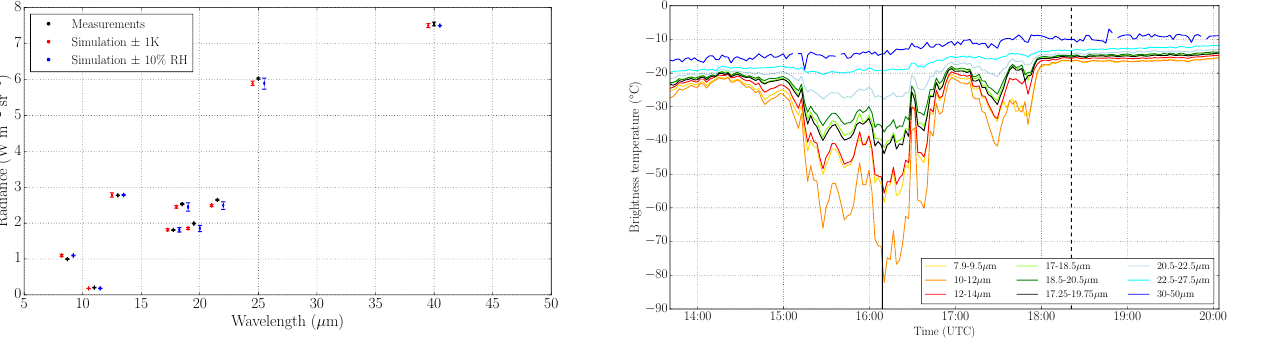
Figure 13. Time series of FIRR brightness temperatures for the 21 February 2015 experiment. The vertical lines indicate when the measurements shown in Fig. 14 were